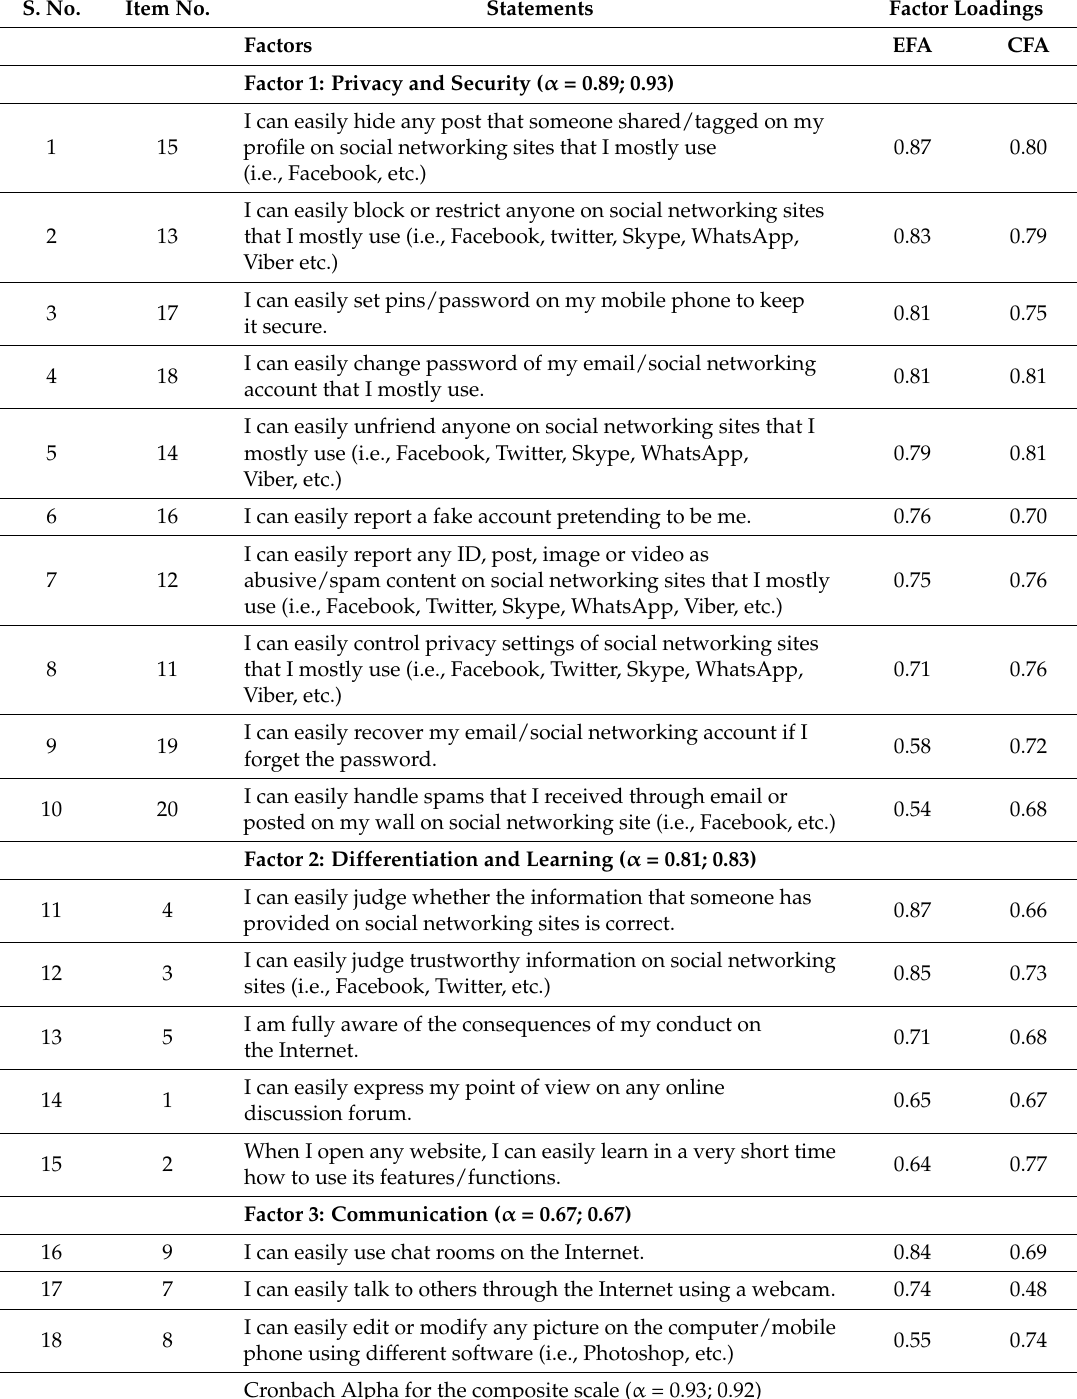
Table 1. Factor analysis of ICT Self-Efficacy